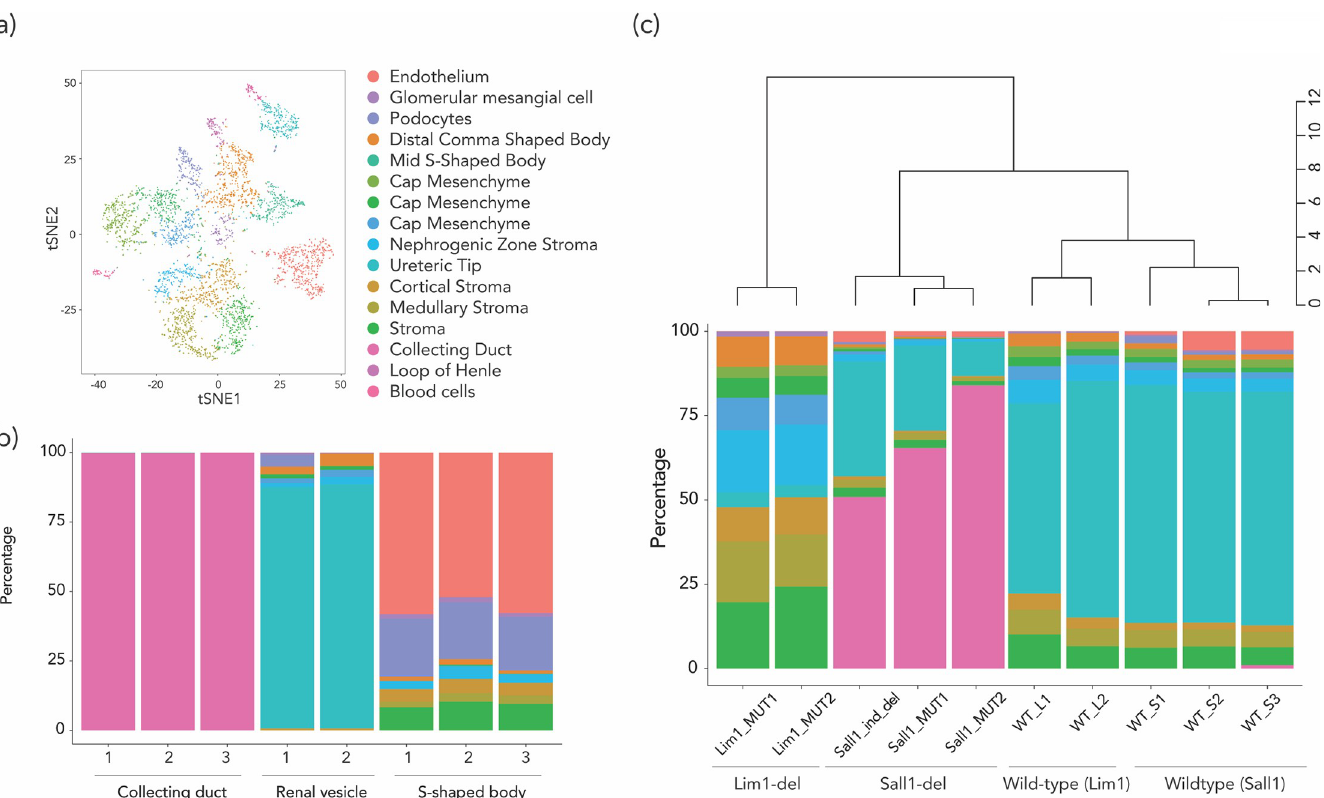
Fig 4. The estimation of cell subtype proportion using e14.5 mouse kidney scRNA-seq data showed the applicability of scRNA-seq data for the deconvolution approach. (a) The scRNA-seq analysis of e14.5 mouse kidney identified 16 cell type clusters in total. We performed cell subtype proportion estimate on (b) microdissected samples (collecting duct, renal vesicle, and s-shaped body) from e14.5 kidney and (c) conditional knockout mouse models.